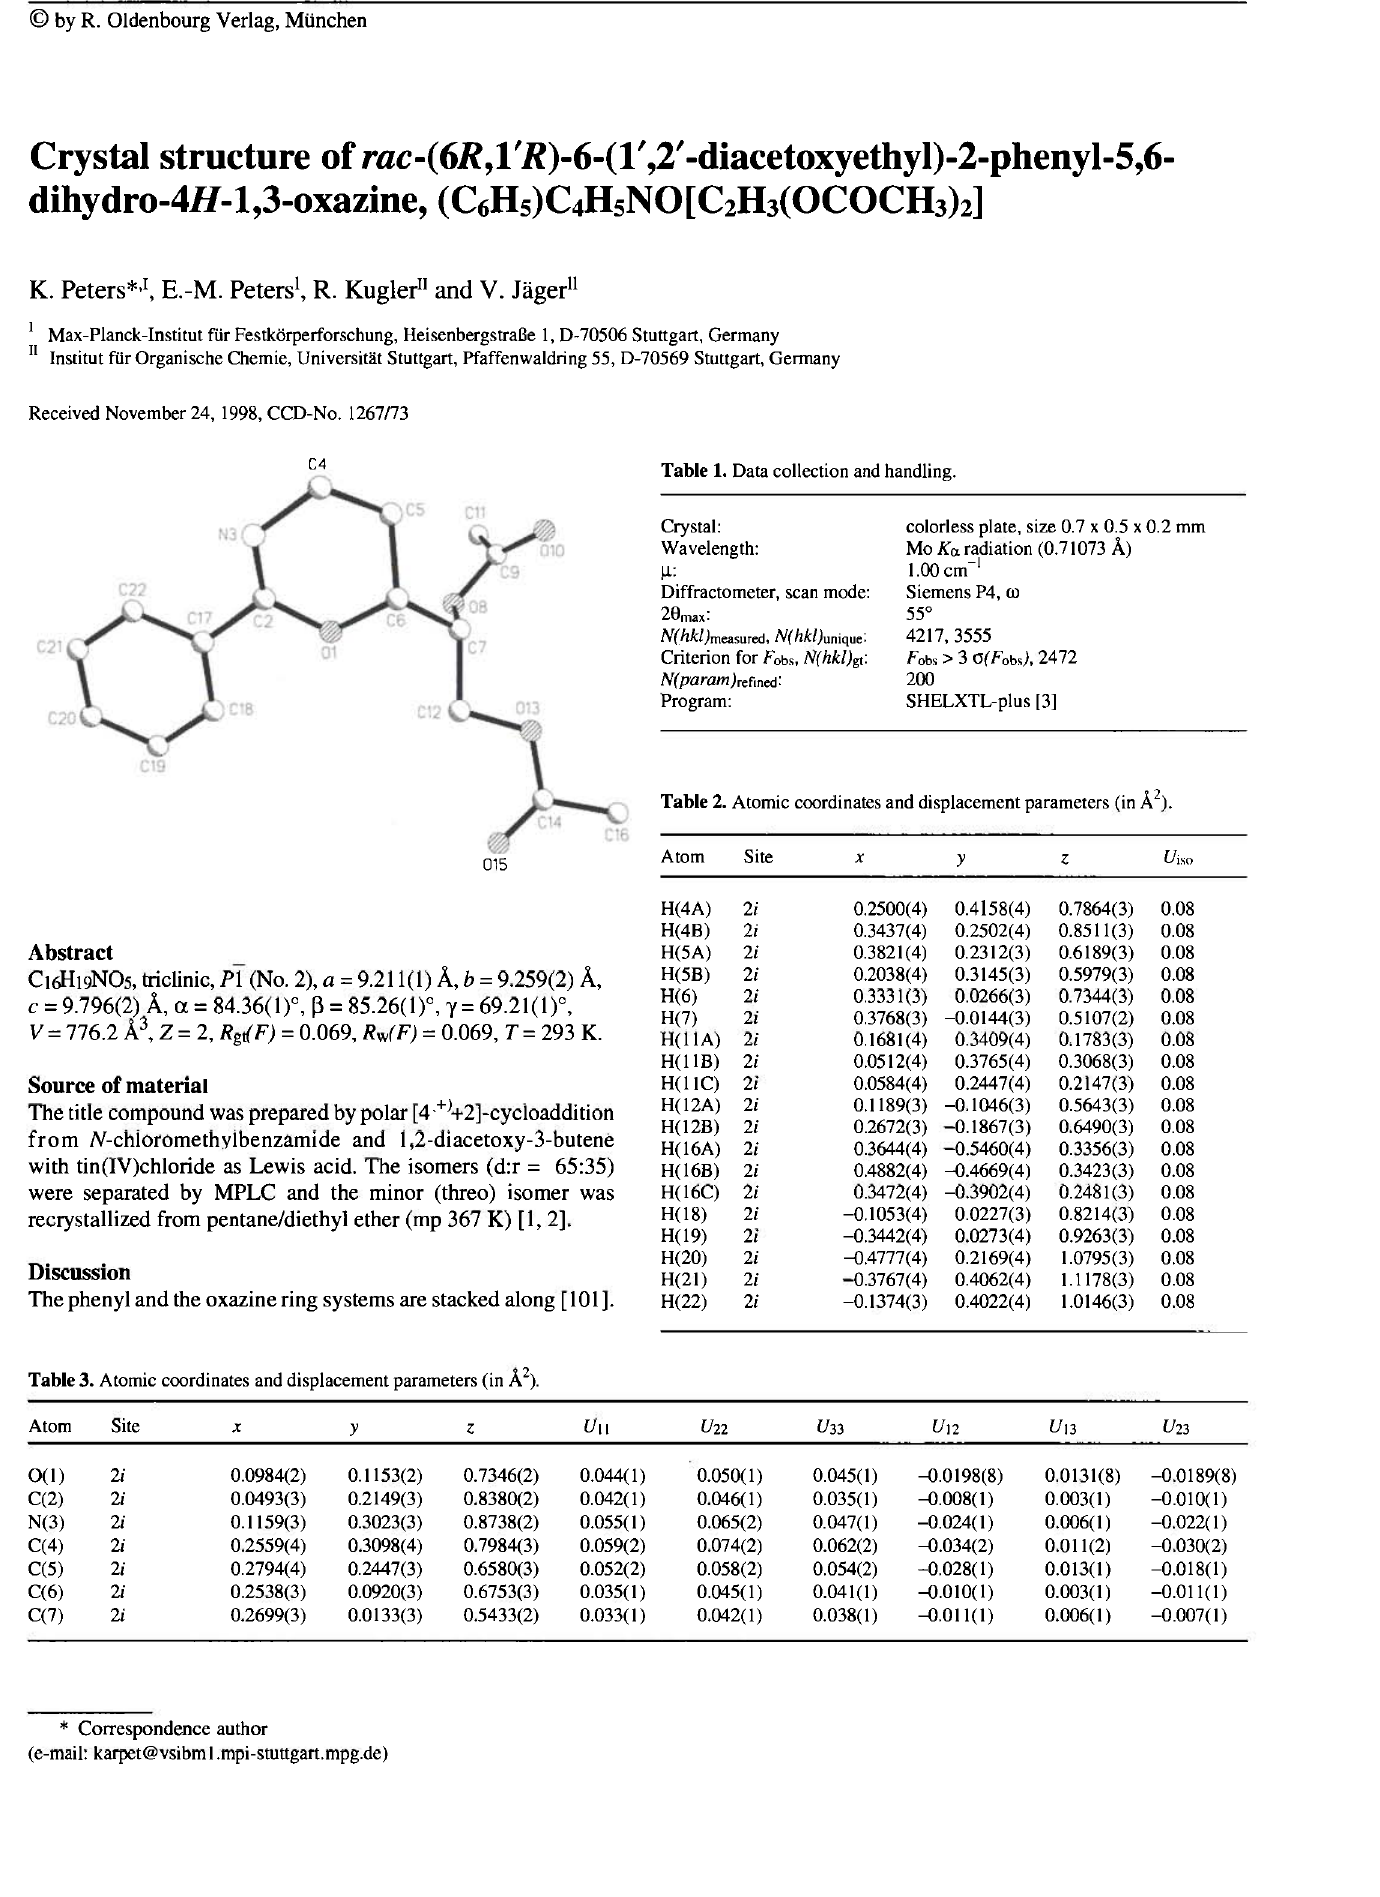
Table 3. Atomic coordinates and displacement parameters (in Ä 2